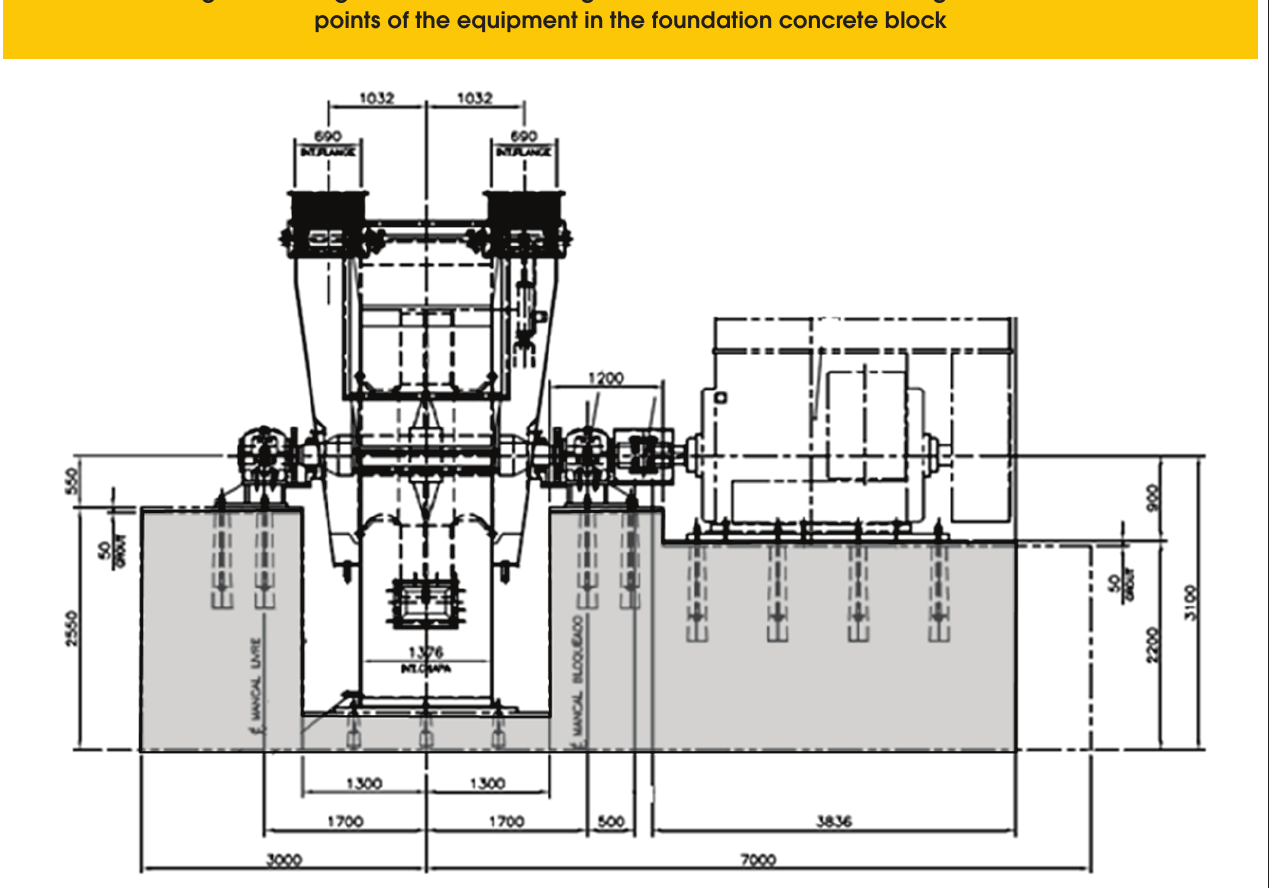
Figure 2 – Longitudinal section through the axis of the blower showing the fixation points of the equipment in the foundation concrete